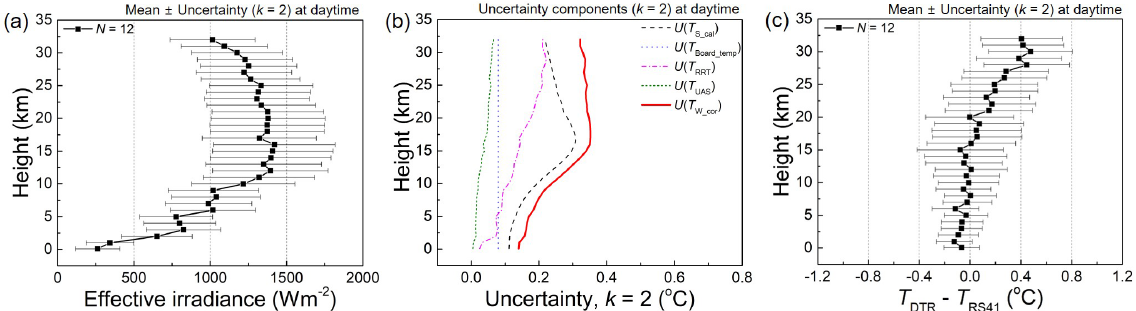
Figure 9. Uncertainty analysis on the DTR and intercomparison with Vaisala RS41. (a) Daytime effective irradiance measured by DTR with uncertainty ( k = 2). (b) Uncertainty factors contributing to the uncertainty of the corrected temperature U(T W_cor ) of DTR in daytime. (c) Temperature difference between DTR and RS41 with DTR uncertainty ( k = 2) at daytime. Table 3. Daytime uncertainty budget on radiation measurement of S = 1141Wm − 2 by DTR at an altitude of 30km. Uncertainty Condition Unit Uncertainty Contribution to uncertainty of factor at 30km ( k = 2) radiation measurement ( k = 2) T W_on − 41 . 5 ◦ C 0.23 106Wm − 2 P 12.6 hPa 0.3 5Wm − 2 v 6.1 ms − 1 0.12 5Wm − 2 S 0 960 Wm − 2 61 73Wm − 2 Fitting error – % 23.4 268Wm − 2 U(S) , Expanded uncertainty for radiation 297Wm − 2 measurement of 1141Wm − 2 ( k =